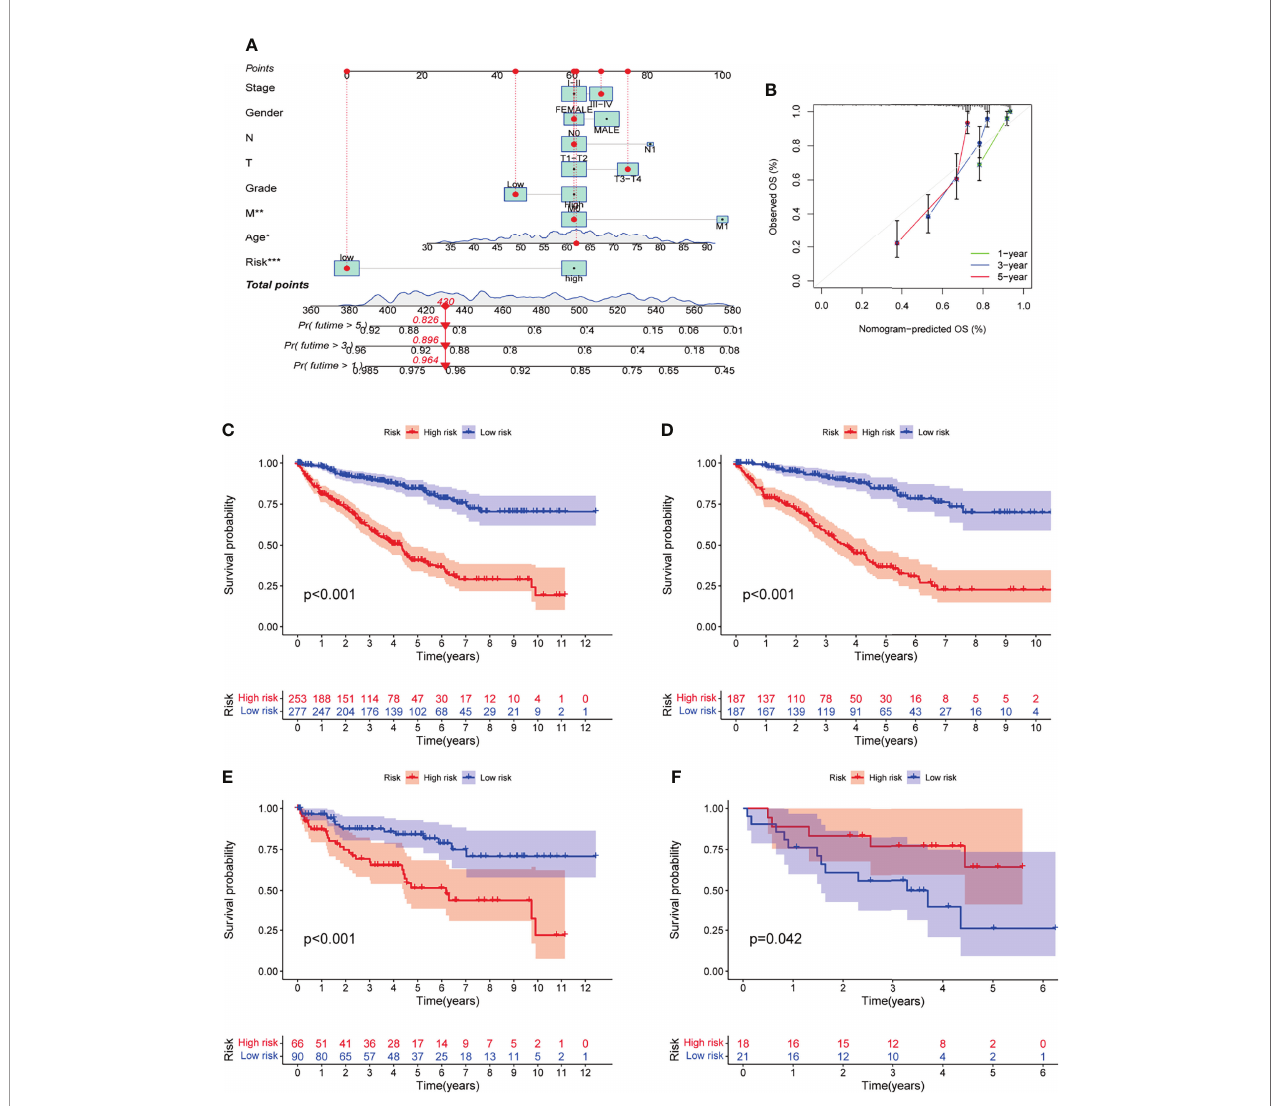
FIGURE 4 | Establishment and evaluation of nomogram. (A) Nomogram was constructed by the prognostic model risk score, patient age, gender, stage, grade, and TNM Staging based on multivariate regression analysis. (B) 1-year, 3-year and 5-year calibration curves. (C – F) Kaplan-Meier survival curves for prognostic models of entire TCGA cohort, TCGA training cohort, TCGA testing cohort, and